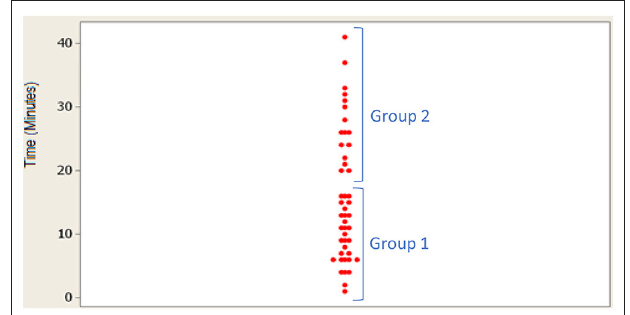
FIGURE 5 | Plot of individual values of the time spent by the pathologist to examine a slide (activity 34 of the biopsy operations flowchart).